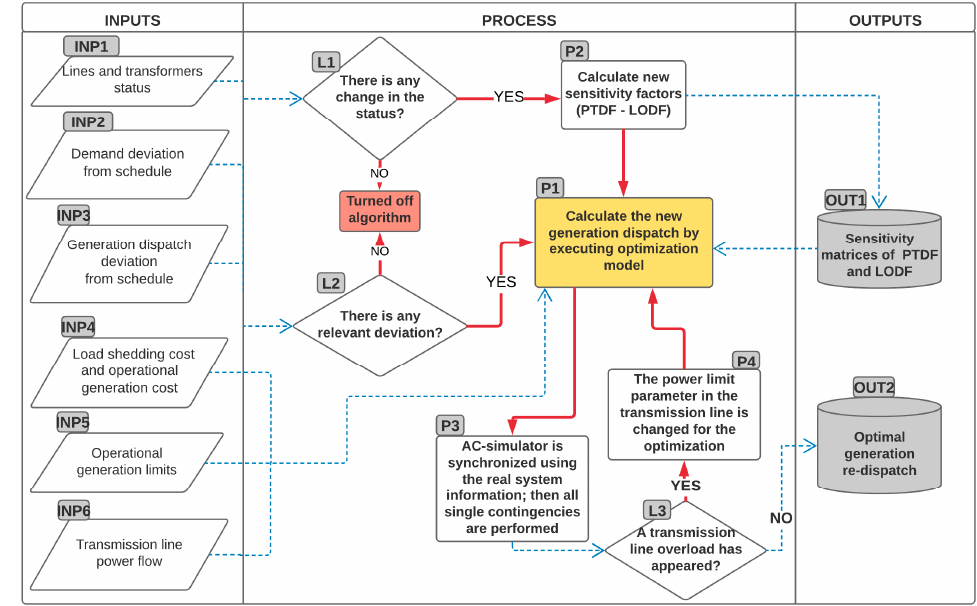
Figure 1. First algorithm for the online economic dispatch.